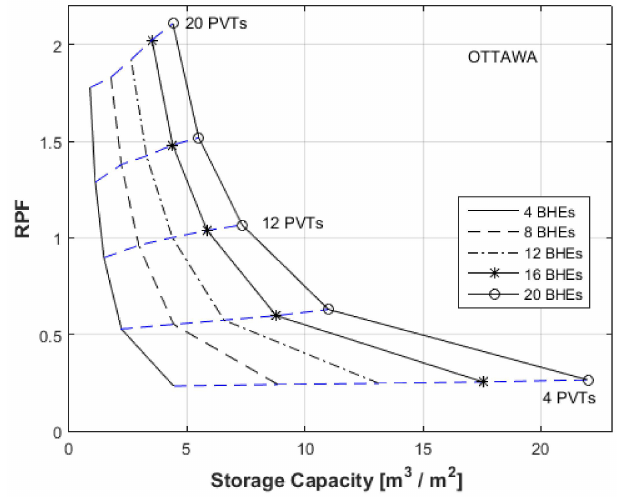
Figure 6. RPF for Ottawa as function of the storage